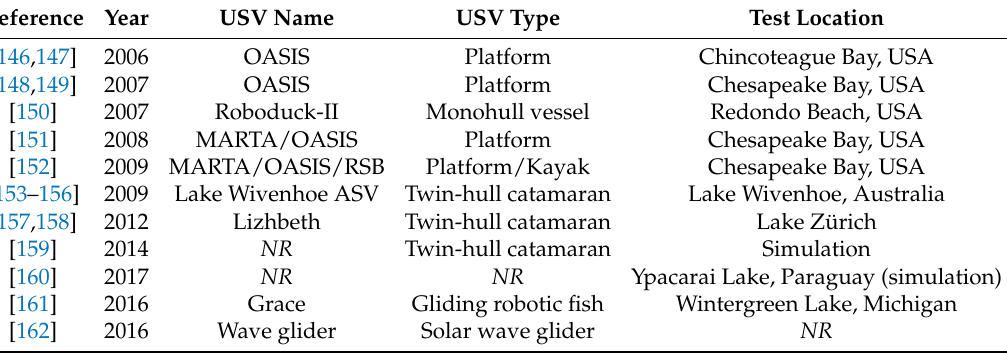
Table 4. Characteristics of work related to chemical hazards grouped by task, where “NR” stands for “Not